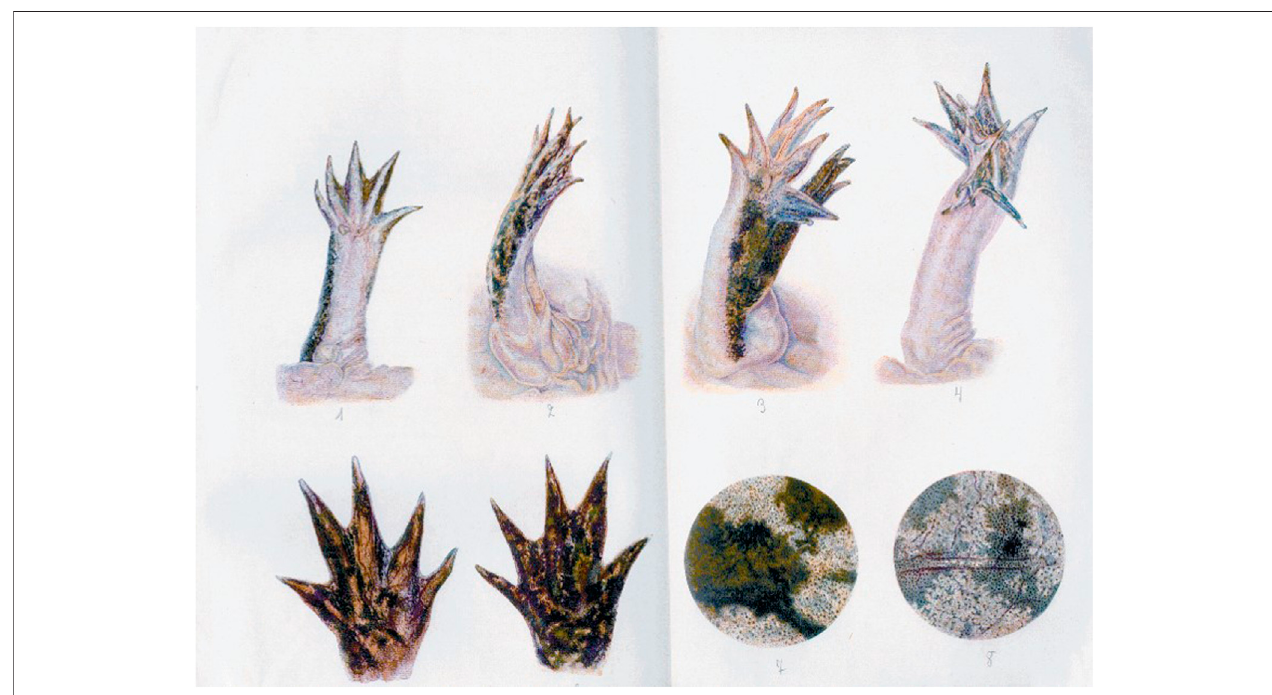
FIGURE 4 | Illustration from Schaxel ’ s “ Untersuchungen ” . It shows the different ways in which he had used regeneration as a